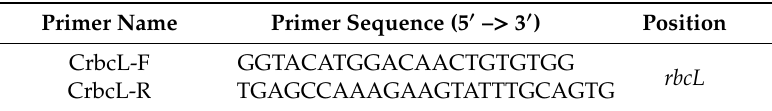
Table 3. Novel DNA barcode primers for Cuscuta species.